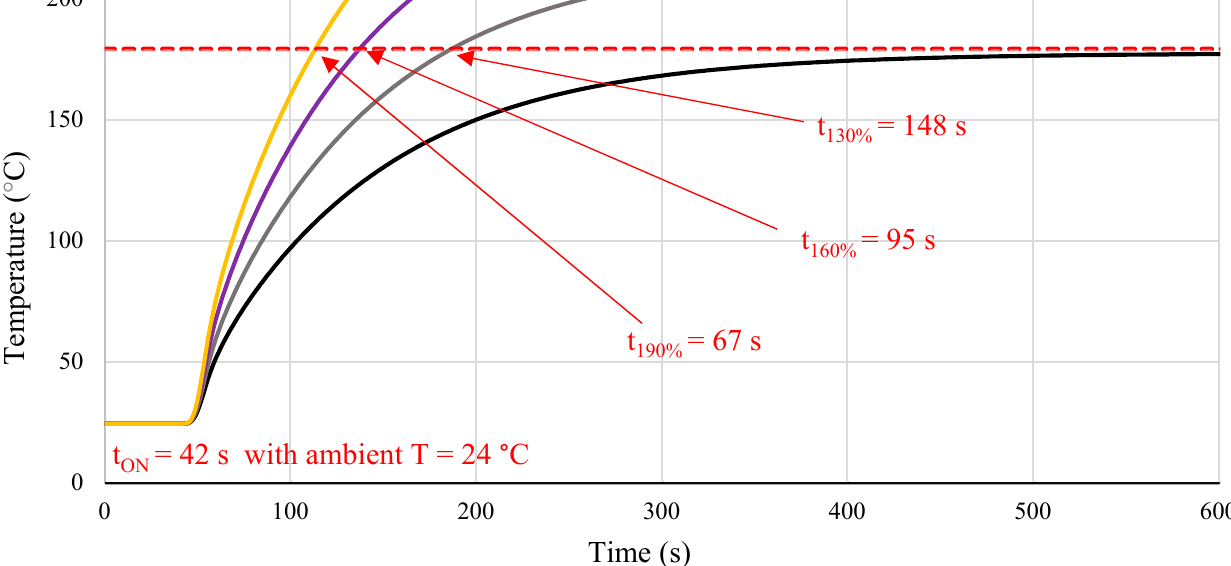
Figure 11. Power increase vs. time to reach 180 ◦ C in a hot spot of the device. COMSOL Multiphysics simulation